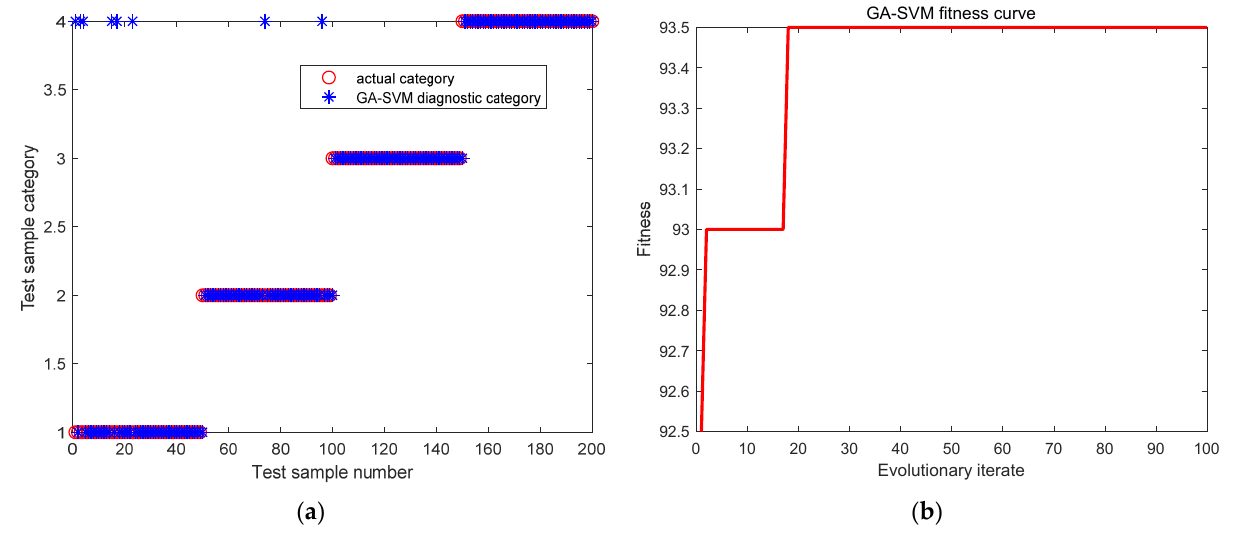
Figure 10. The test results based on traditional SVM model. ( a ) The classification results ( b ) The fitness change curve.